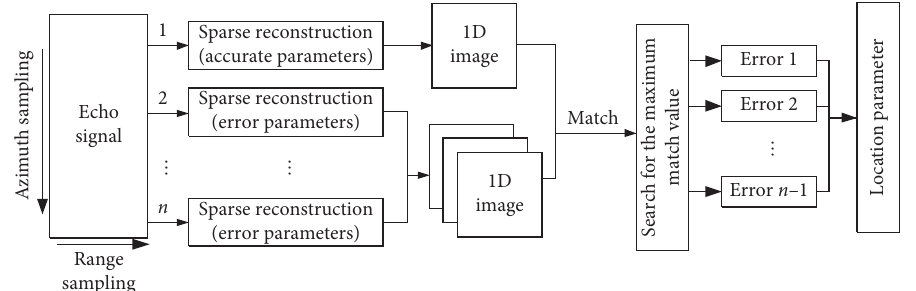
Figure 3: Process of position estimation method based on reference position coordinate and relative error.